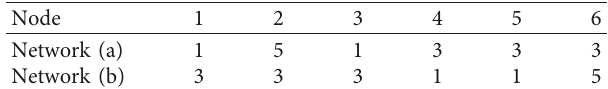
Figure 1: Six-node network model. Networks (a) and (b). Table 1: Network node